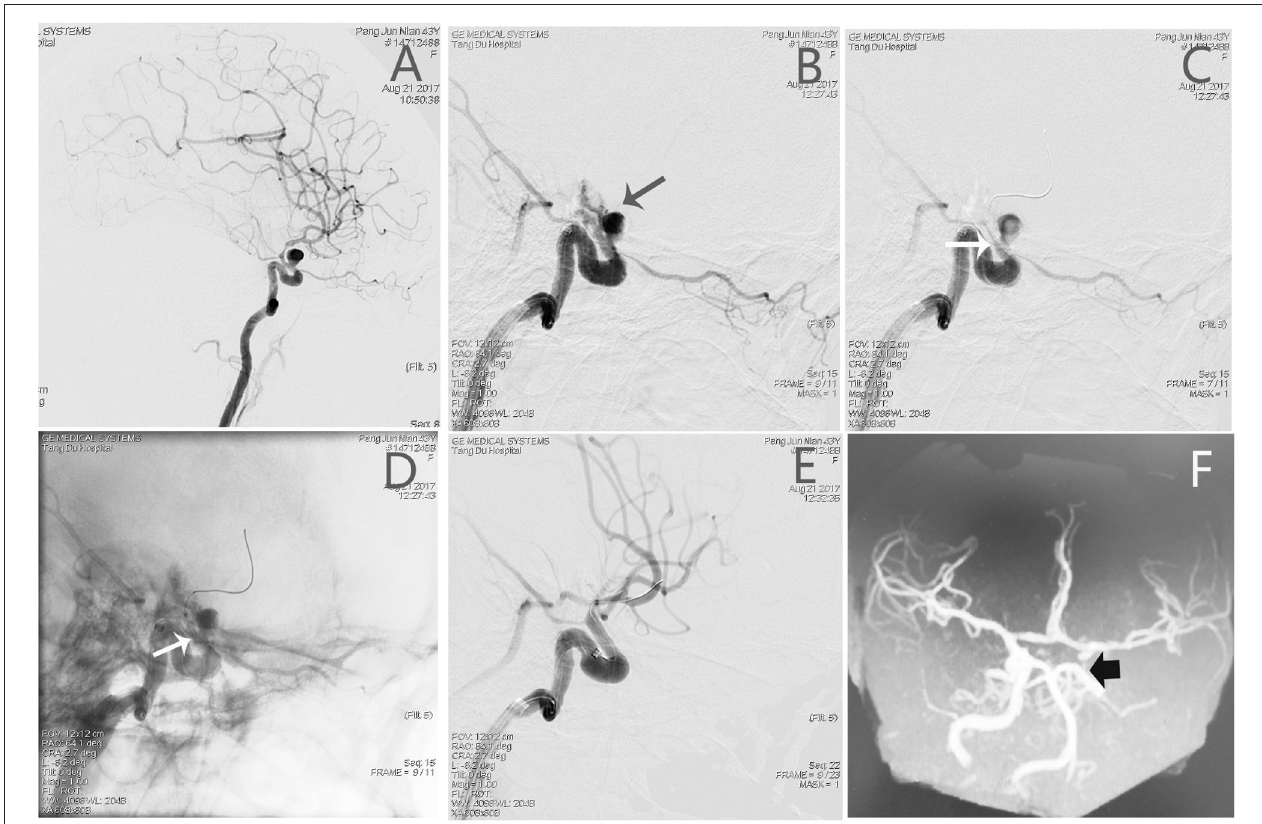
FIGURE 2 | Angiographic images of a 43-year-old woman (see Patient No. 3 in Table 1 ) with a L-ICA C6 BBA. (A) A BBA (3.8*6.9mm) located on the anterior wall of the C6 segment. (B) The aneurysm ruptured during preoperative angiography (black arrow). (C,D) A 3.5*10-mm WCS deployed immediately (white arrow). (E) Postoperative angiography showing complete aneurysm occlusion, and the OA was also affected. (F) The MRA images showing the L-ICA was occluded